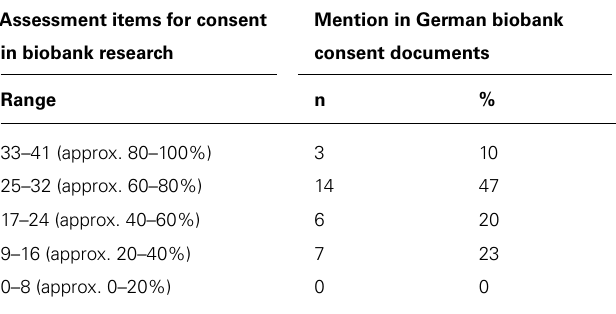
Table 2 | Distribution of assessment items ( n = 41, divided into five ranges) for consent content in biobank research, found in consent documents of a German biobank sample ( n = 30)